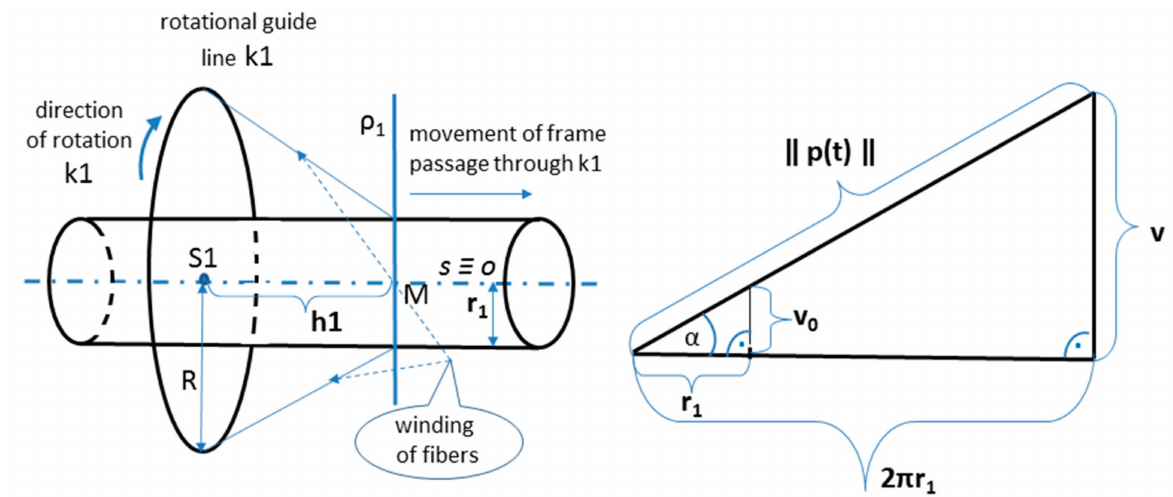
Figure 6. Schematic representation of the passage of the frame through the rotating guide-line k1, the plane of the winding of the fibers ρ 1 and the distance h1 of the plane from the guide-line (on the left), h1 = (cid:107) S1M (cid:107) . Characteristic triangle of the helix on the right (r 1 —radius of the helix, v 0 —reduced pitch, v—the pitch of the helix, α – angle slope that is referred to as winding angle, (cid:107)(cid:107) p(t) (cid:107)(cid:107) length of helix p (t) for t ∈ (cid:104) 0, 2 π (cid:105) ) (on the